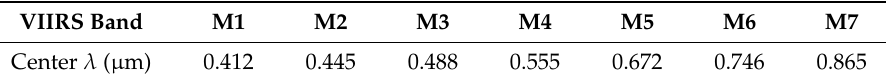
Table 1. Wavelength of VIIRS RSBs used in monitoring SD degradation.